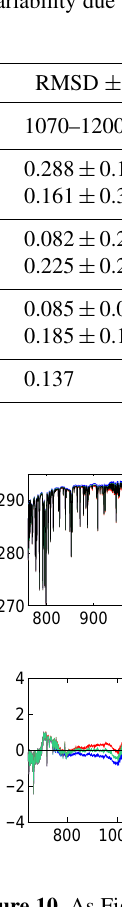
Figure 10. As Fig. 9, for the case of 3 July (low aerosol load). Av- erage residuals are computed over 18 IASI